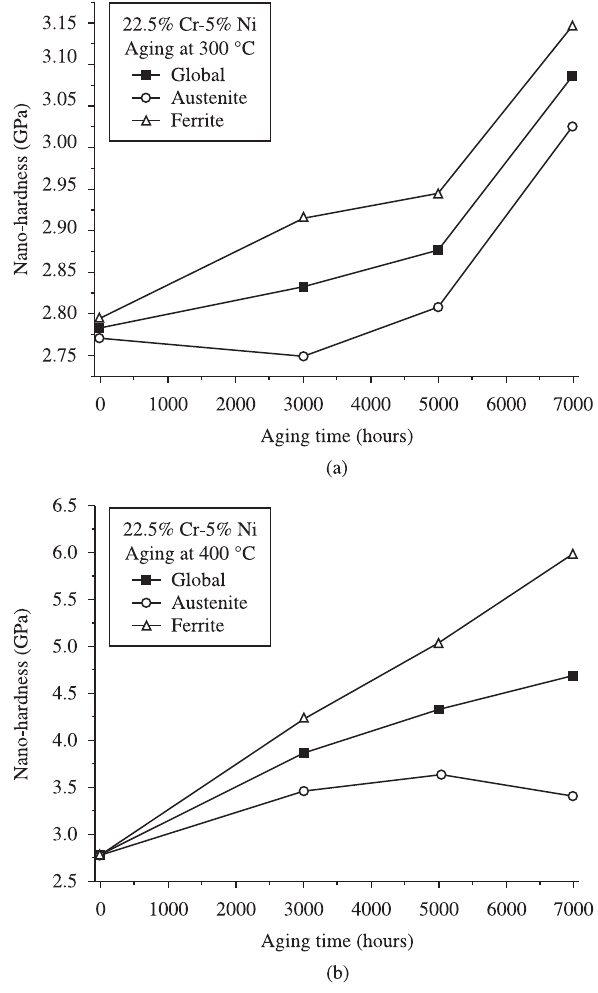
Figure 6. Effect of aging time on the overall hardness and nanohardness of ferrite and austenite phases: a) Aging at 300 ° C and b) aging at 400 ° C. Error: ±0.10.